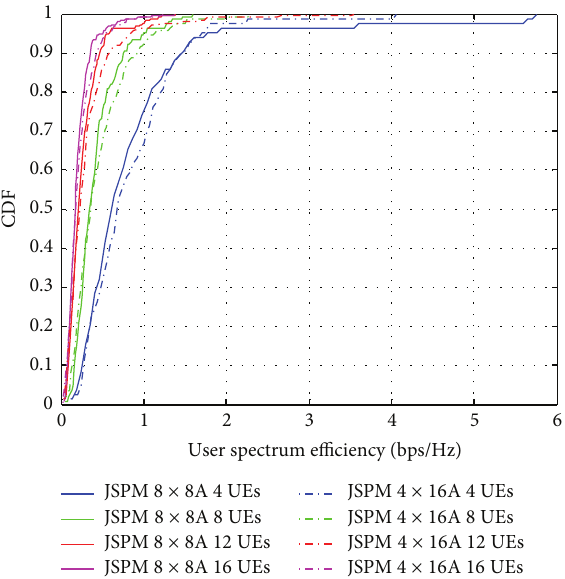
Figure 8: CDF of UE spectrum